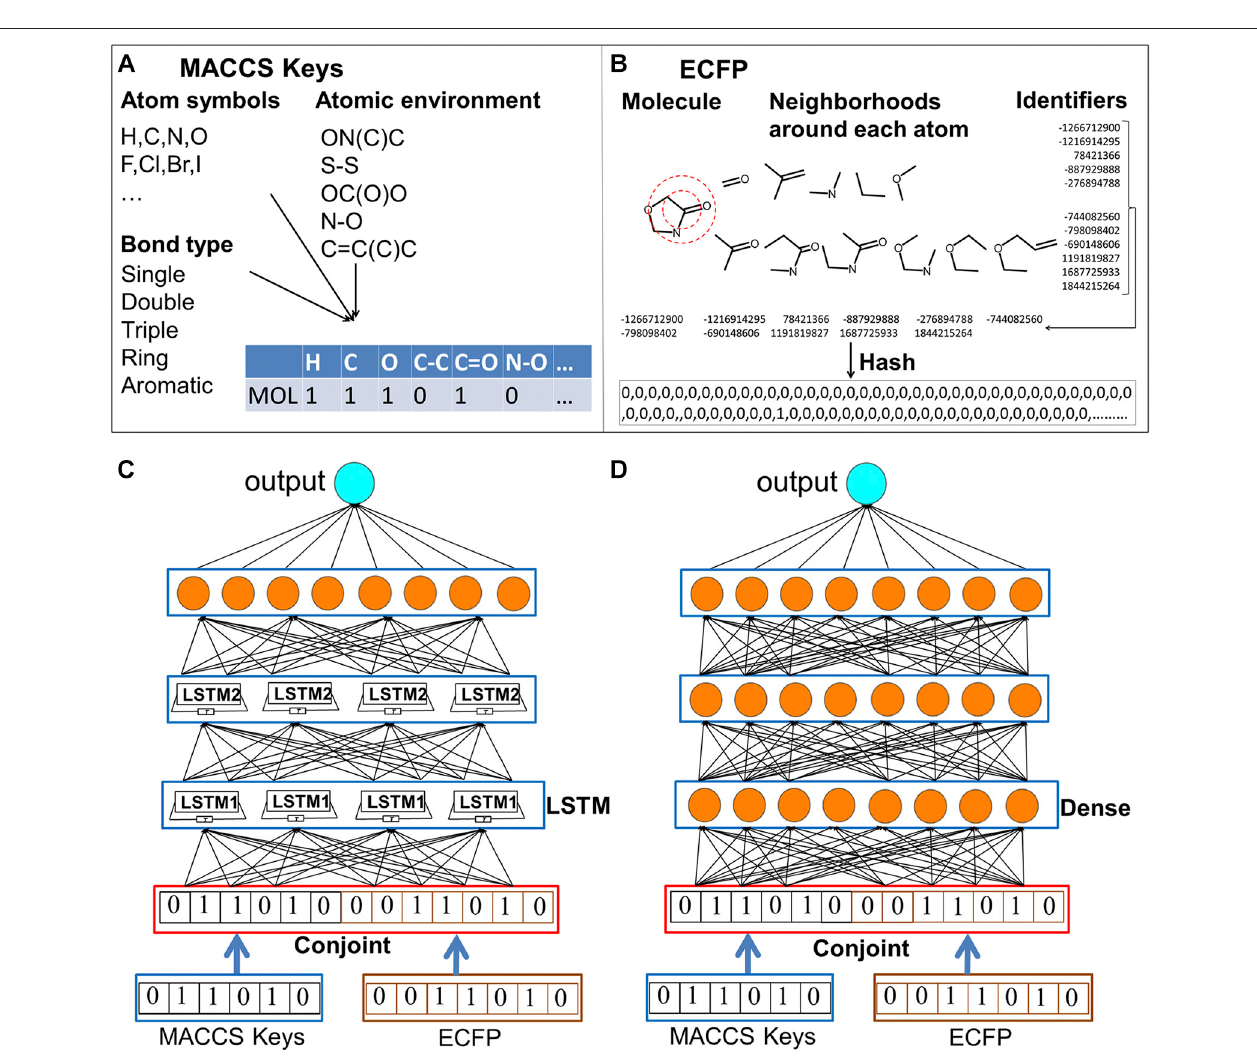
FIGURE 1 | The schematic computing procedures of MACCS keys, ECFP fi ngerprints and the conjoint fi ngerprints for LSTM and DNN. One molecule is transformed to its feature(vector) space representation using MACCS keys and ECFP fi ngerprints. Two types of fi ngerprint are combined asconjoint fi ngerprint. Output ofdeepneuralnetworkisthepredictedproperties. (A) schematiccomputingproceduresofMACCSkeys; (B) schematiccomputingproceduresofECFP fi ngerprints; (C) LSTM trained with conjoint fi ngerprint; (D) DNN trained with conjoint fi ngerprint.